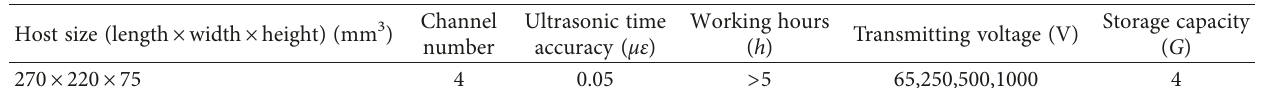
Figure 13: Video capture of the roadway floor detection borehole. (a) Complete floor rock stratum. (b) Fracture. (c) Crack. (d) Broken. Table 5: Main parameters of the mine ultrasonic transmitter.